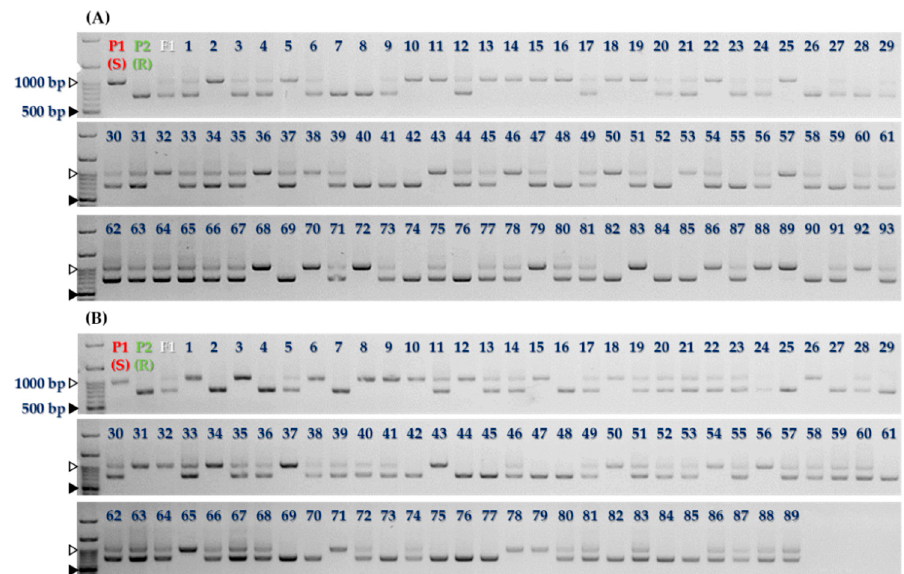
Figure 4. Banding pattern of InDel marker in resistant, susceptible lines (P1, SCNU-C-3328; P2, SCNU-C-3328), F 1 and F 2 generation. Inoculated with Xcc race 6 ( A ), Xcc race 7 ( B ). R, resistant; S, susceptible. Filled triangle; 1000 bp ladder, unfilled triangle; 500 bp ladder.